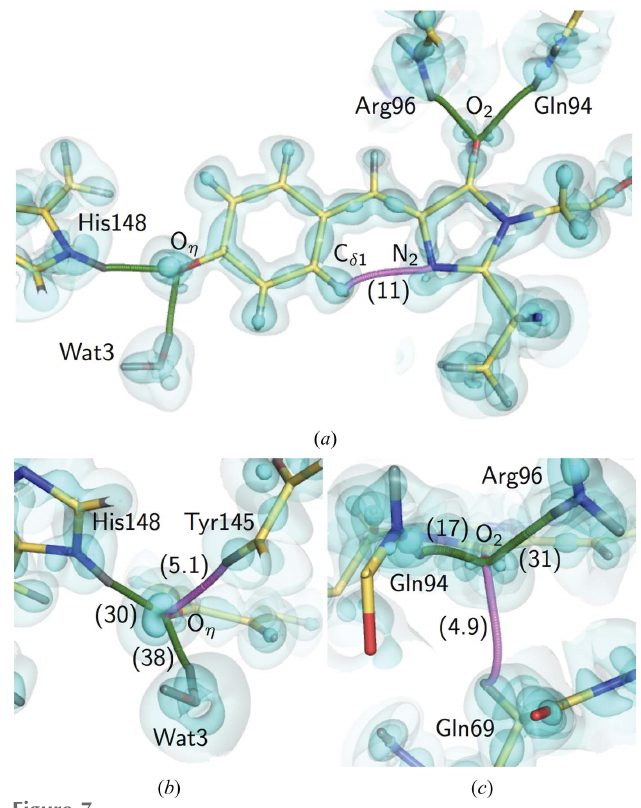
Figure 7 The hydrogen bonding based on the MAM. ( a ) The bond paths of hydrogen bonding along the electron distribution of the chromophore. ( b ) Details of the bond paths around O (cid:10) . ( c ) Details of the bond paths around O 2 . The cyan surfaces represent the deformation electron density at contour levels of +0.01, +0.15 and +0.5 e A˚ (cid:5) 3 , respectively. The bond paths for conventional hydrogen bonds are represented as green curves, while those for nonconventional bonds are represented as pink curves. The D e values for hydrogen bonds (in kJ mol (cid:5) 1 ; listed in Supplementary Table S5) are shown in